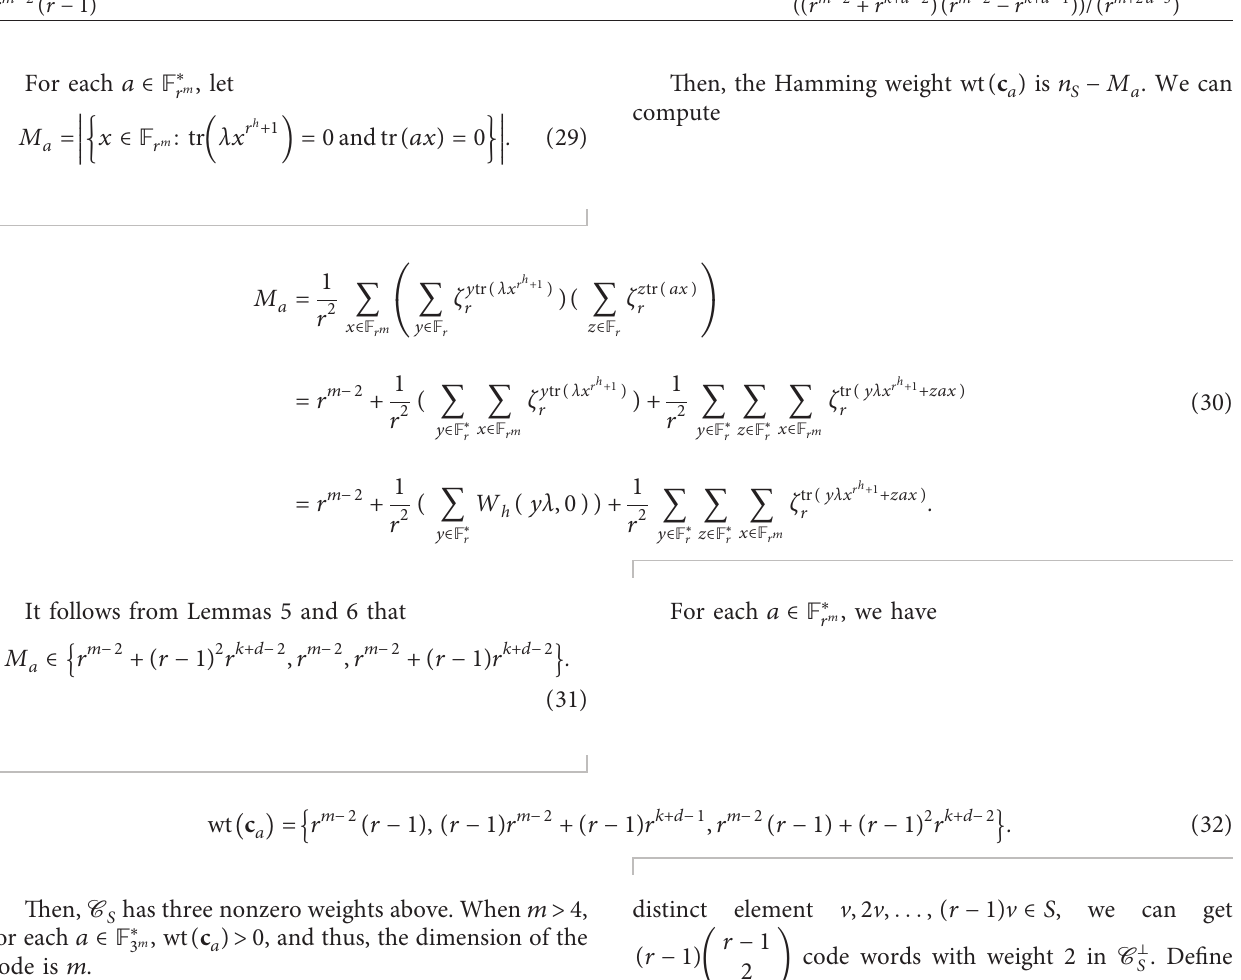
Table 9: Weight distribution of C